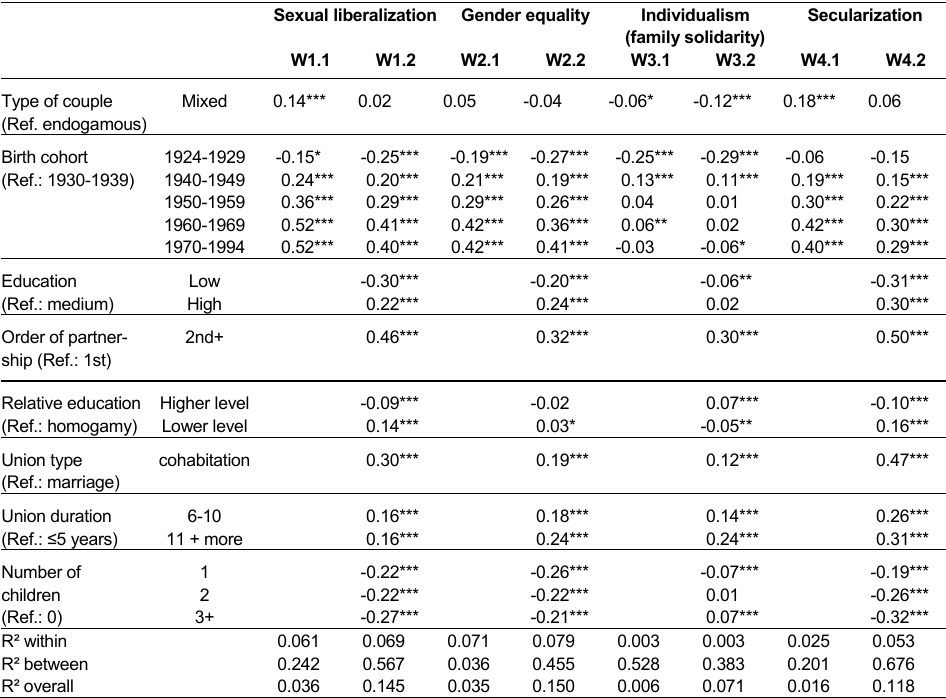
Table 2.1 : Results of linear regression models for attitudes among native women Sexual liberalization Gender